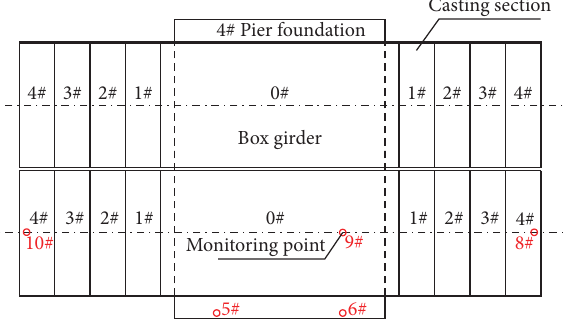
Figure 6: Casting sections and monitoring points on 4# pier.